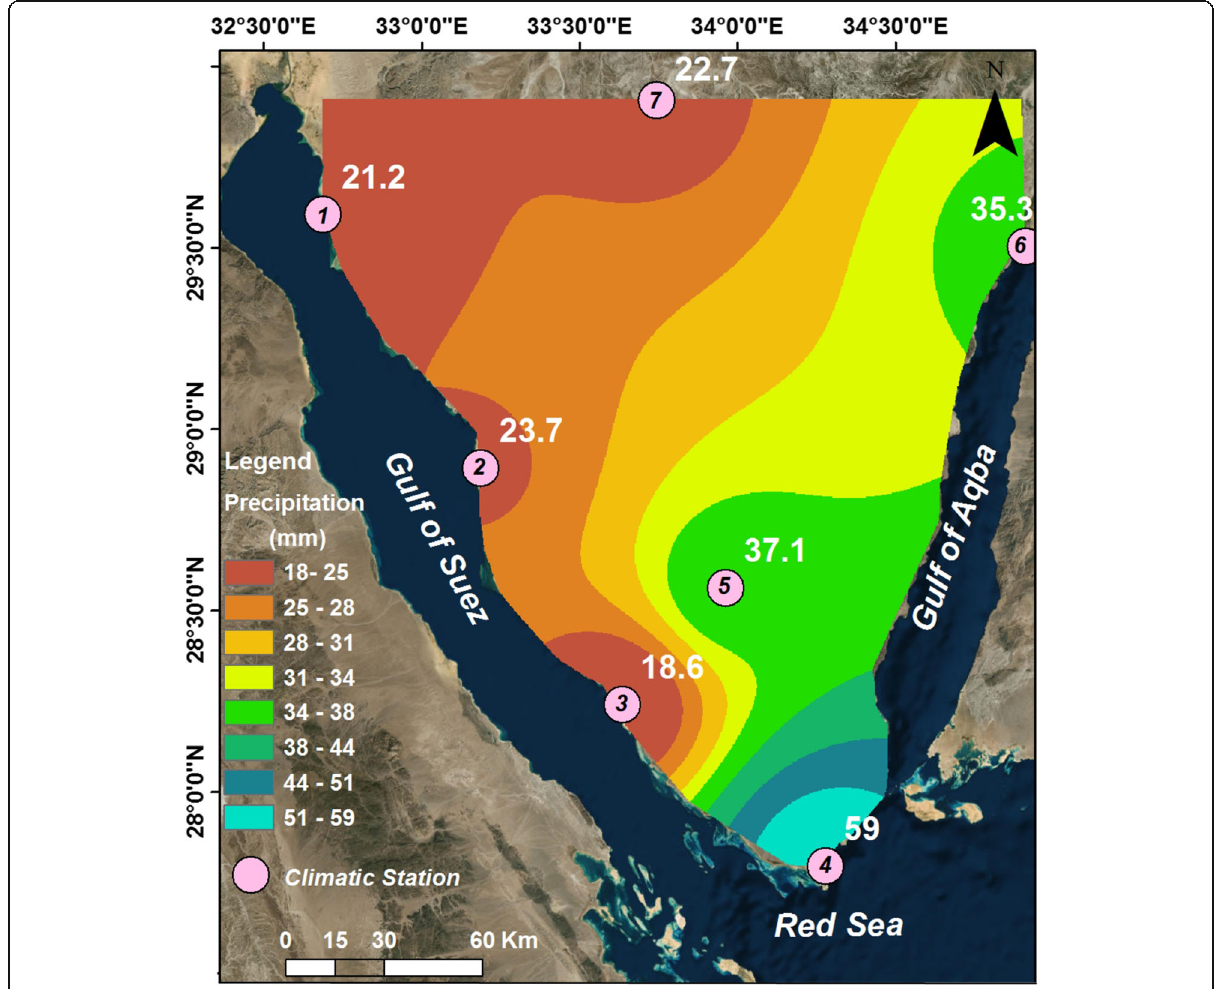
Fig. 4 Contour map of the maximum precipitation in 1 day for 7 meteorological stations (1976-2010), clarify that Sharm El Sheikh has the highest record (59 mm) in comparison with other stations. The rainfall data have been obtained from the following meteorological stations (1 Taba, 2 Abu Rudis, 3 El Tor, 4 Sharm El Sheikh, 5 Saint Kathrin, 6 Taba, and 7